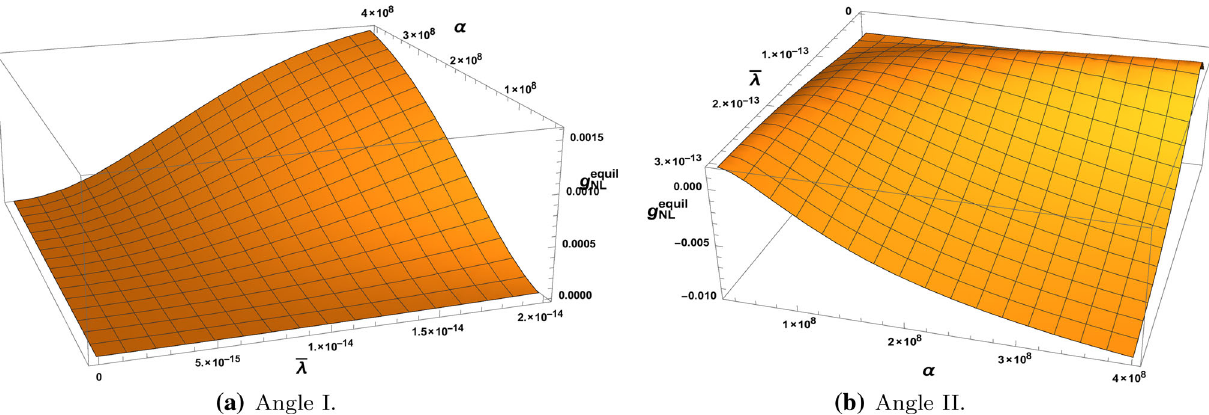
Fig. 23 Representative 3D diagram for equilateral non-Gaussian three point amplitude vs. the model parameters α and ¯ λ for N cmb = 60 in two different angular views